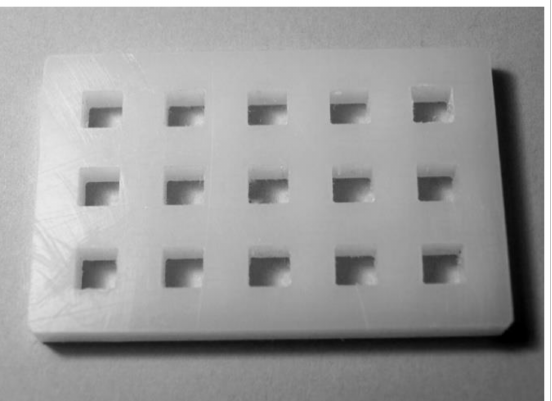
Figure 2. A plastic plate constituting the matrix for the production of test material